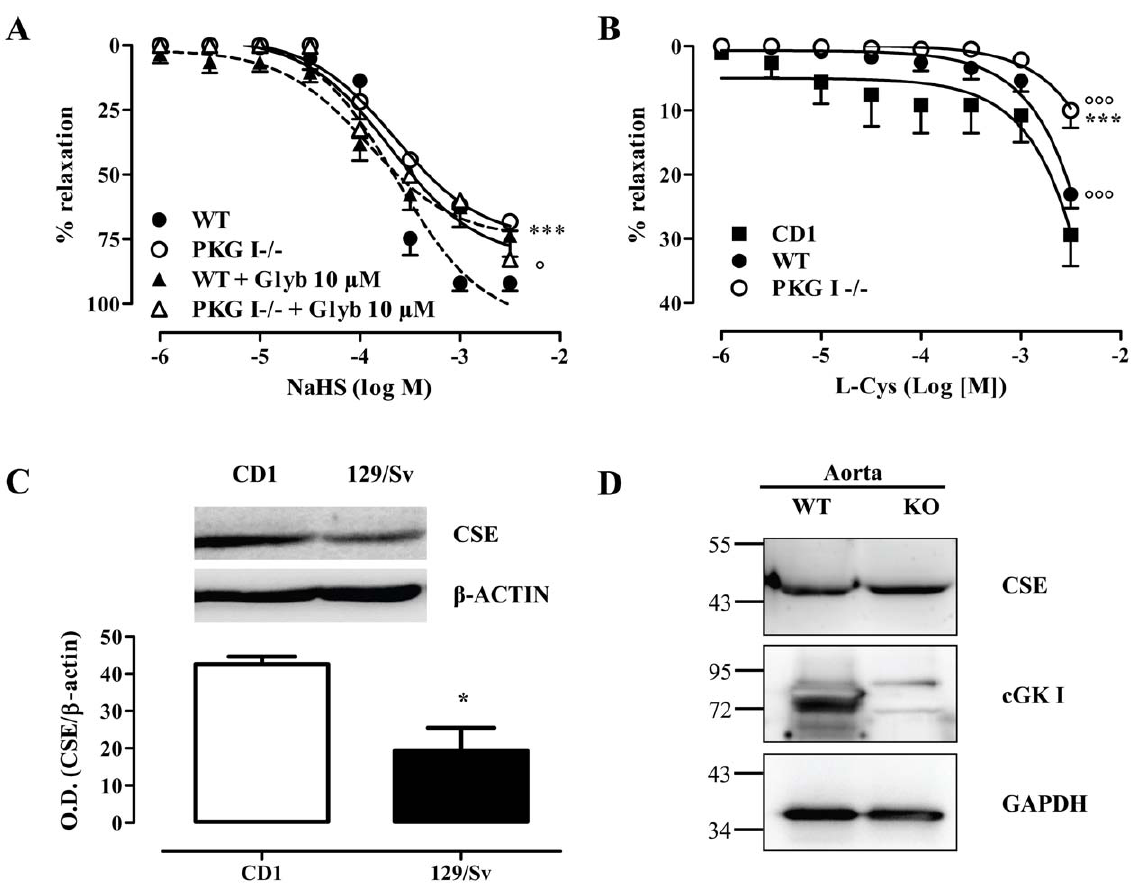
Figure 5. PKG contributes to the relaxing effect of exogenous and endogenous H 2 S. (A) Mouse aortas from wild-type or PKG-I 2 / 2 animals were pre-treated with vehicle or glibenclamide (10 m M, 30 min) and then incubated with the indicated concentration of NaHS (n=6 rings harvested from 3–4 animals); dashed lines are used for wild-type animals, while solid lines are used for knockouts. (B) L-cysteine-induced vasodilatation of aortic rings pre-contracted with phenylephrine from wild-type and PKG-I 2 / 2 mice. Note that cumulative concentration-response curves to L-cysteine were significantly different among the different strains of mice used CD1 vs 129/Sv (WT); uuu p , 0.001 vs. CD1, *** p , 0.001 vs WT, n=8 rings harvested from 3–4 animals for each group (C) Representative blot and quantitation depicting aortic CSE expression in 129/Sv vs CD-1; n=3 for each group, *p , 0.05. (D) Representative blot showing expression of CSE in aortic homogenates in wild-type and PKG-I 2 / 2 mice. Experiments were performed twice with similar